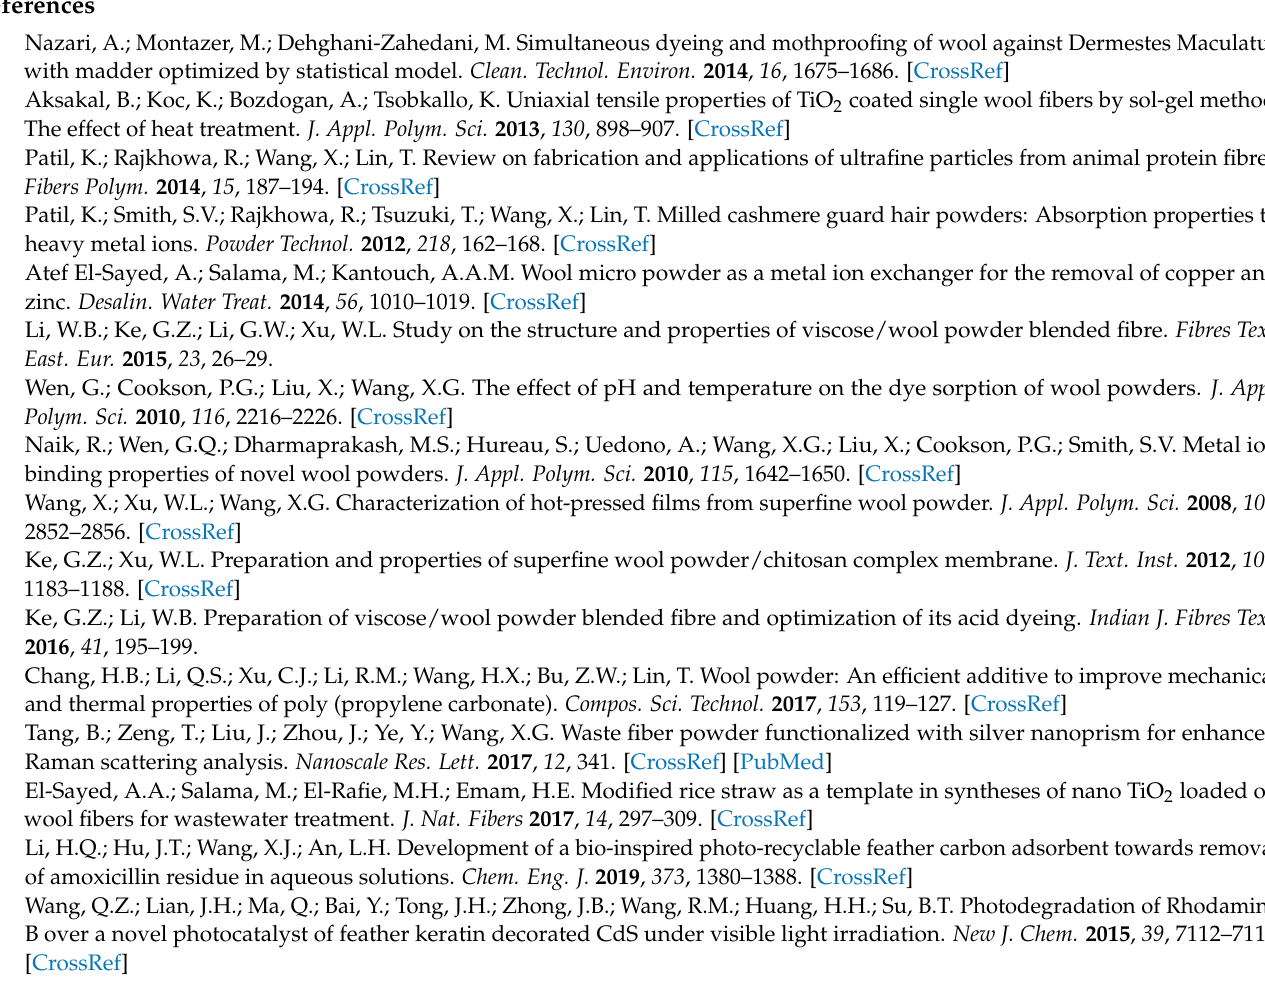
of 155 mW/cm 2 for 150 min, Figure S8: Effect of the co-catalyst H 2 O 2 on the photo-degradation efficiency of MB dye solution exposed to white light at the light power density of 155 mW/cm 2 for 120 min, Figure S9: Effect of a gas environment on the photo-degradation efficiency of MB dye solution exposed to white light at the light power density of 155 mW/cm 2 for 180 min, Figure S10: Comparison of photo-degradation efficiency of MB dye solution under different testing conditions for 90 min, Figure S11: Comparison of photo-degradation of MB, CR and MO dye solution by the WT powders under 155 mW/cm 2 white light irradiation for 120 min, Figure S12: Recycle photo- degradation of MB dye solution by the WT powders under 155 mW/cm 2 white light irradiation for 90 min, Figure S13: Trapping experiments for photo-degradation of MB dye solution by the WT powders by adding 1.0 mM EDTA, 1.0 mM BQ, 1.0 mL TBA, and 1.0 mL FFA, respectively under 155 mW/cm 2 white light irradiation for 120 min, Table S1: The XPS elemental analysis data, Table S2: The fitting parameters of the time-resolved PL spectra using biexponential decay